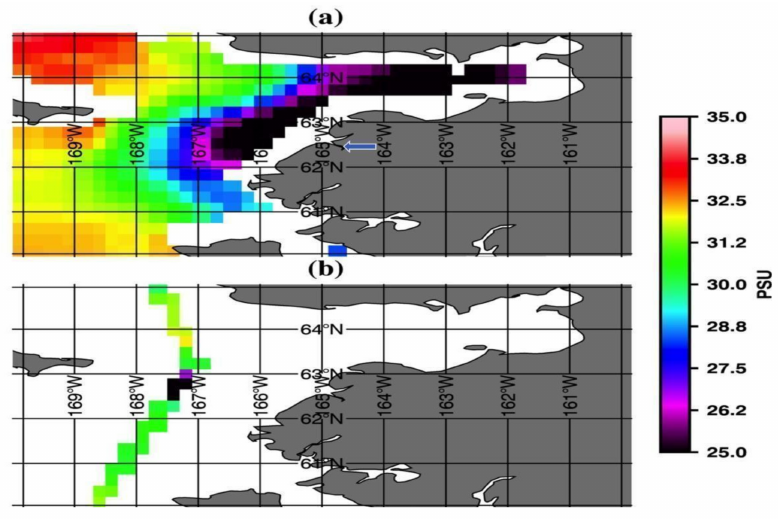
Figure 2. ( a ) Map of mean SSS derived from RSS70km product over the period of the Saildrone deployment. ( b ) Saildrone SSS from SD1036 along the deployment track. Blue arrow shows the location of Y-K